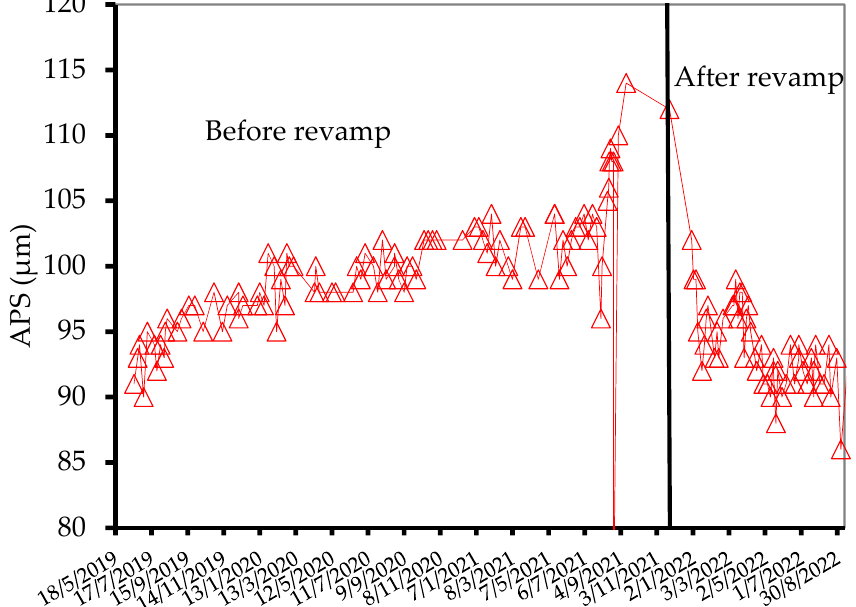
Figure 4. Variation in average particle size (APS) of E-Cat before and after the revamp. Table 4. LNB FCCU performance before and after the revamp.